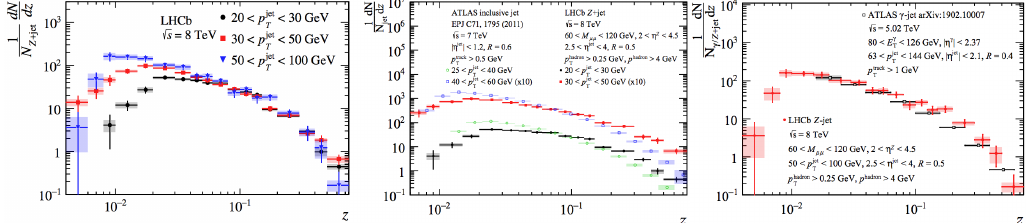
(cid:112) s = 8 TeV (left) and comparisons with ATLAS